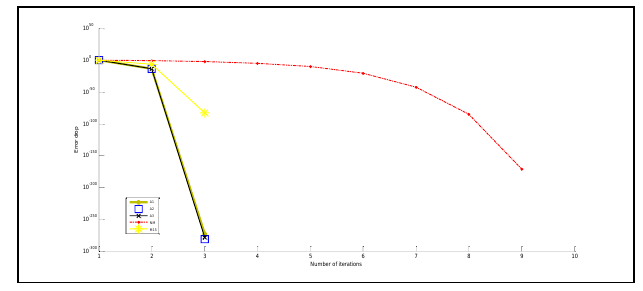
Fig. 5. Error drops for example 2